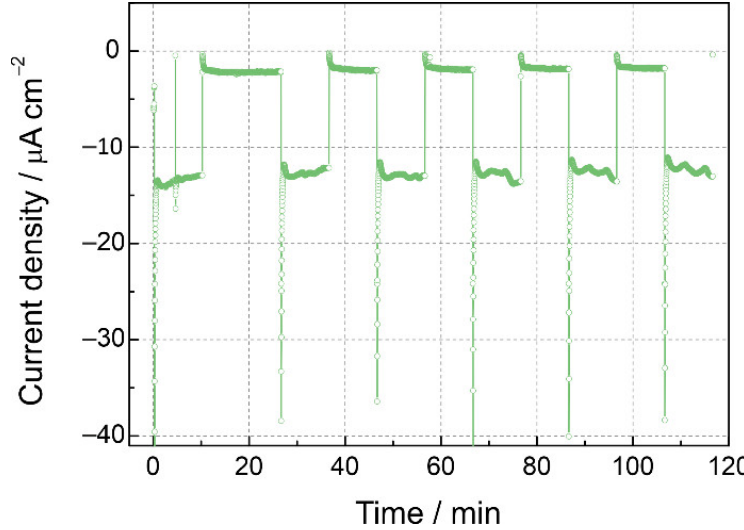
Figure 5. Stability test of LFO/Pt electrode at 0.4 V vs. RHE under chopped illumination in deaerated 0.1 M NaOH solution.